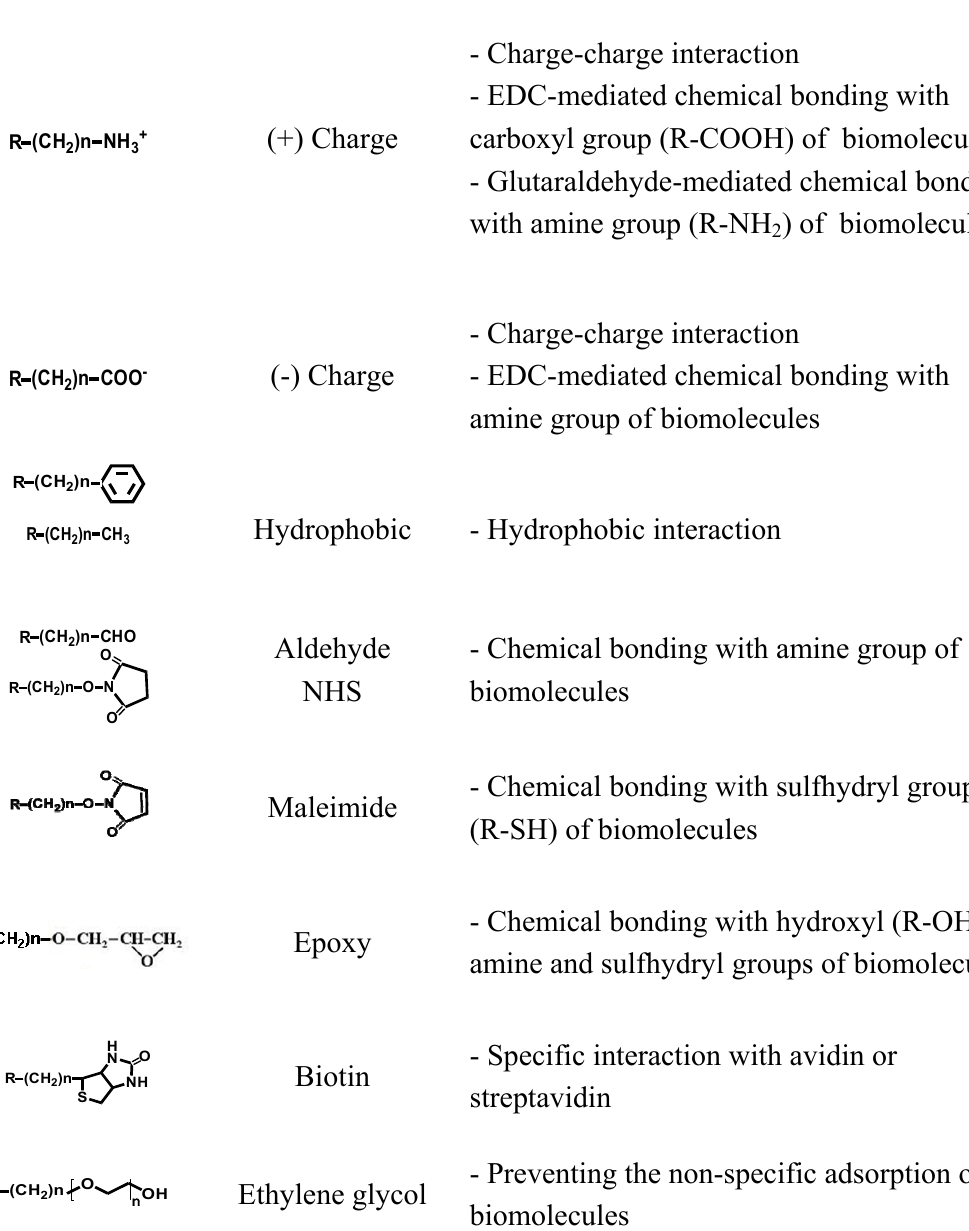
Table 1. Major functional tailgroups for surface